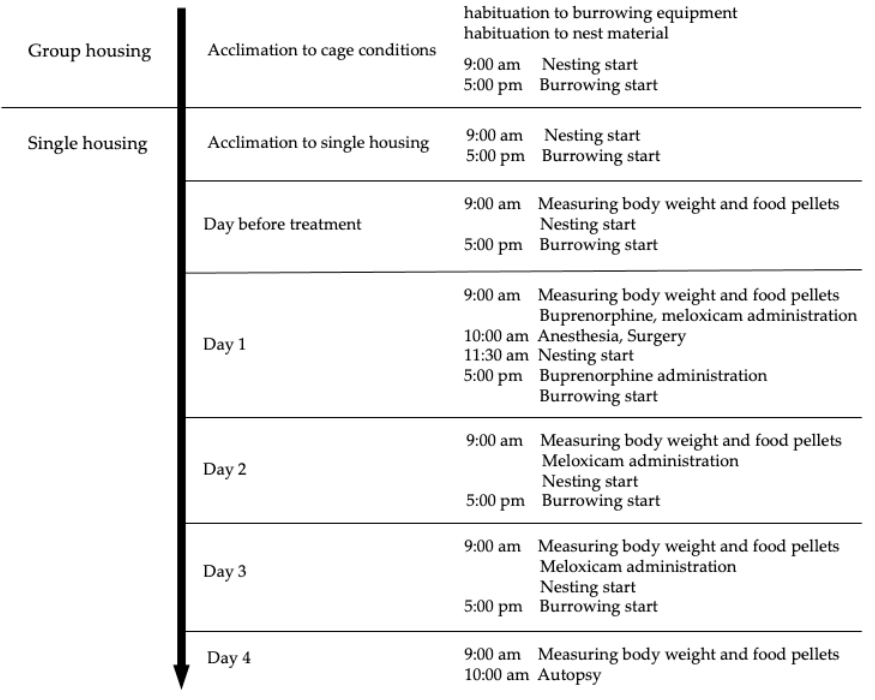
Figure 1. Outline of experimental schedule.